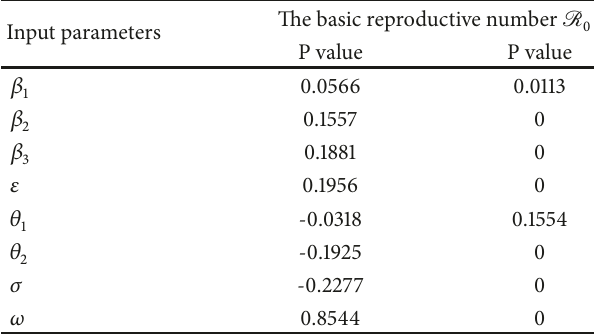
Table 1: Sensitivity values of the basic reproductive number on the